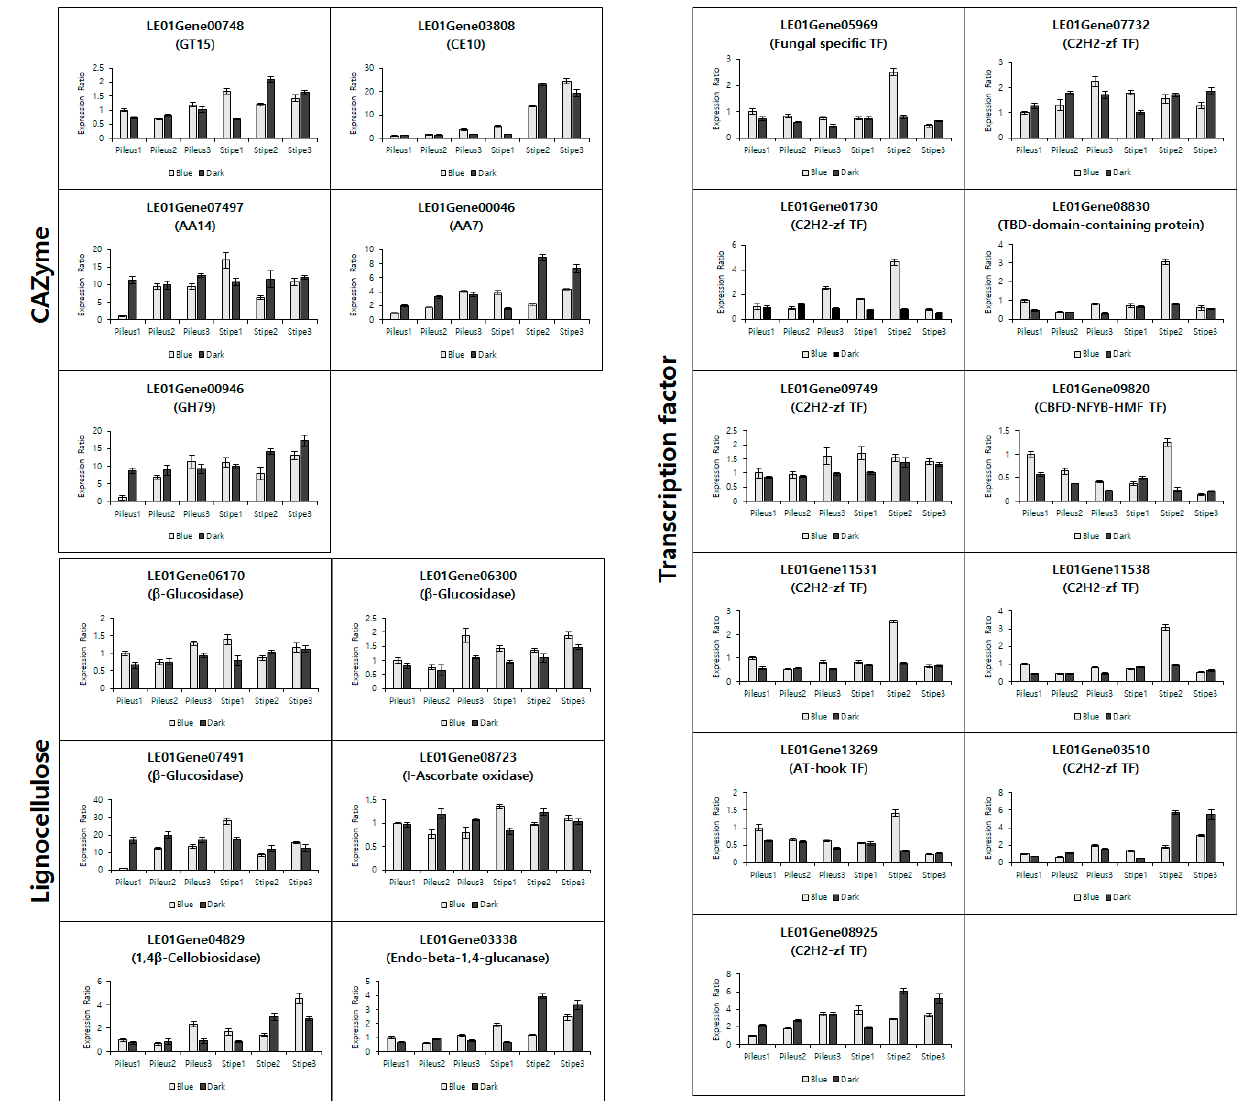
Figure 5. Expression validation of selected DEGs for CAZyme, lignocellulose, and transcription factor using qRT-PCR in mushrooms under blue light and dark (no light) conditions. Each relative expression was normalized by the mushroom Rpl4 housekeeping